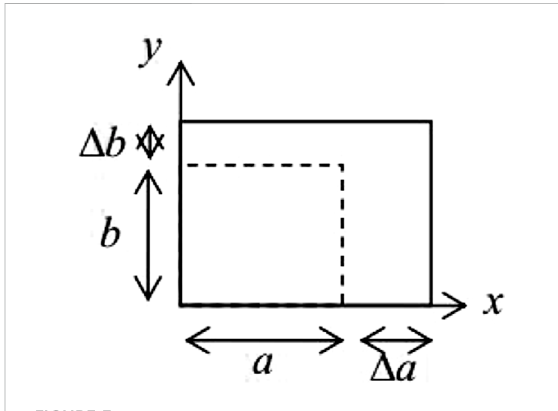
FIGURE 3 Deformation of a material element normal deformation.